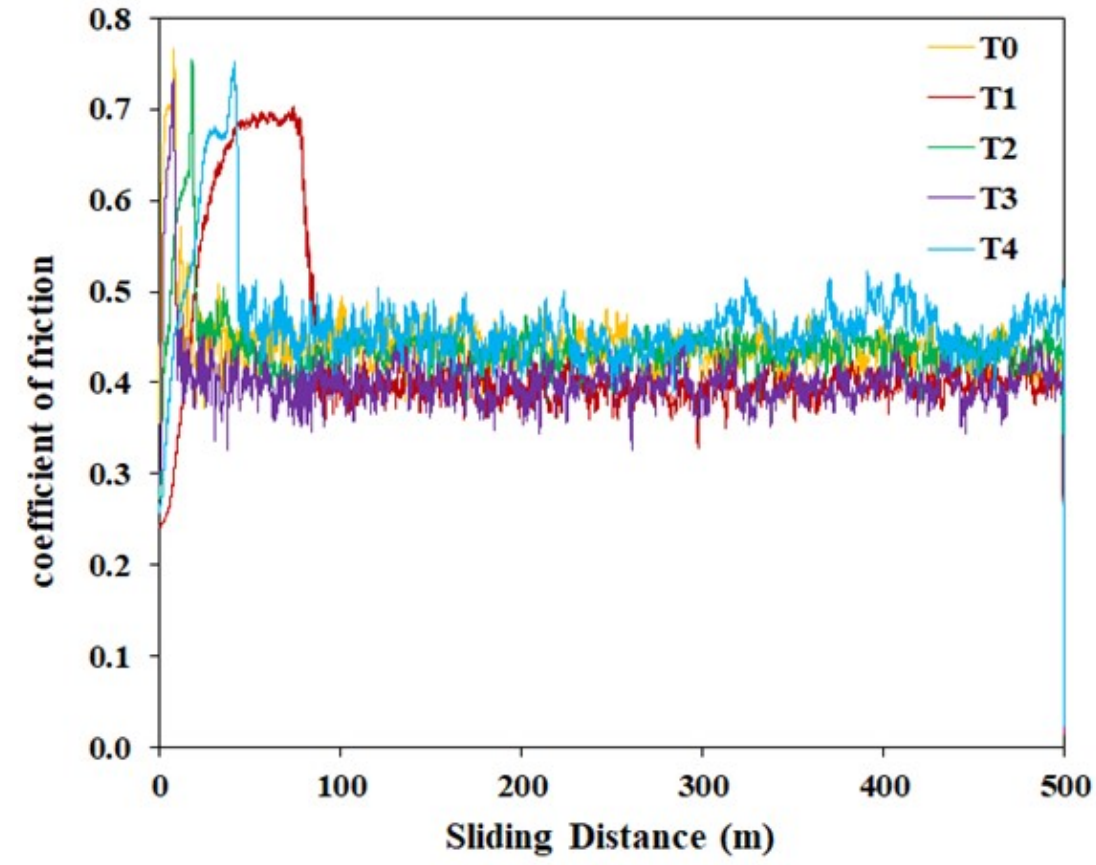
Figure 14. Changes in the friction coefficient according to the wear distance of PEO-coated specimens. Table 5. Data extracted from wear test.